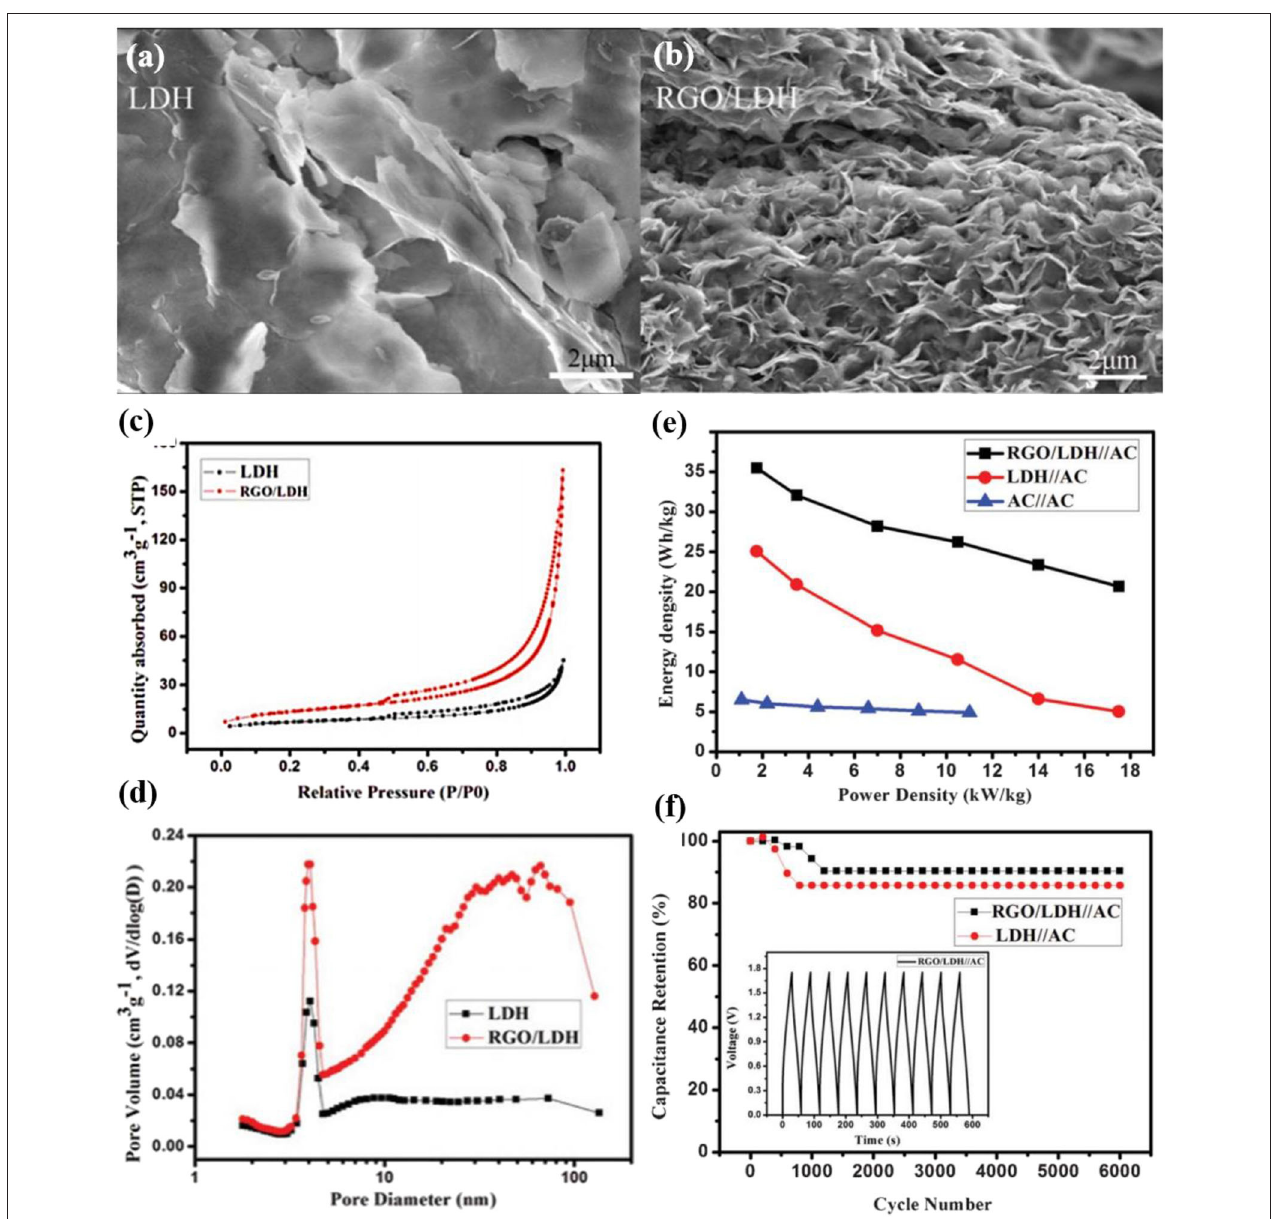
FIGURE 8 | SEM images of (a) LDHs, (b) low-magnification of rGO/LDHs, (c) nitrogen adsorption and desorption isotherm loops of LDHs and rGO/LDHs composite, (d) pore size distribution of LDHs and rGO/LDHs, (e) Ragone plots of LDHs//AC, rGO/LDHs//AC asymmetric ECs, and AC//AC symmetric EC, and (f) Cycle stability of LDHs//AC and rGO/LDHs//AC ECs during charge–discharge test at a current density of 4A g − 1 (Zhang et al., 2013).